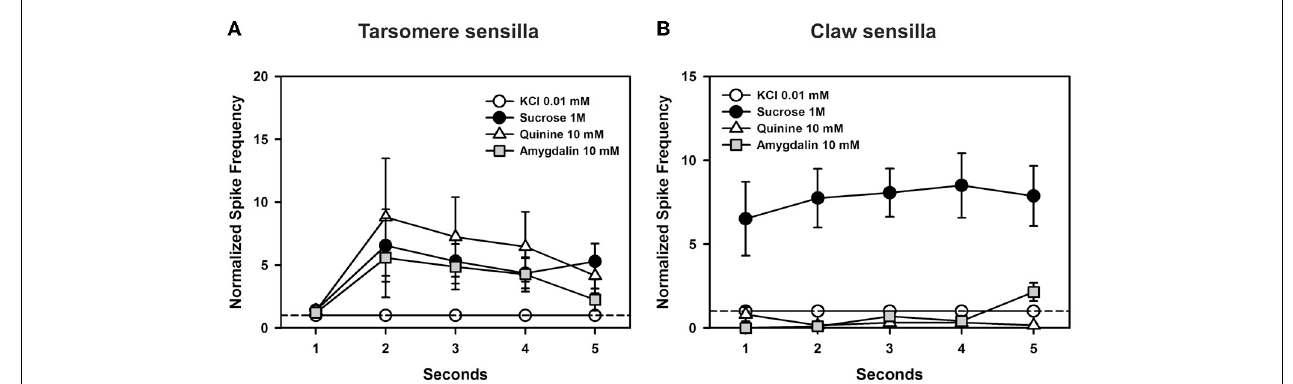
FIGURE 9 | Experiment 6. (A) Chaetic sensilla of the 3rd and 4th tarsomeres. Temporal analysis of mean normalized spike frequencies along five consecutive seconds of stimulation, starting at the onset and finishing at the offset of stimulation. The hatched line shows the reference response to the contact electrolyte KCl 0.01mM. Besides KCl, the curves show the temporal responses upon stimulation with sucrose 1 M, quinine 10mM, and amygdalin 10mM. There were significant differences between seconds of stimulation ( p < 0 . 0005) but within each second, the responses obtained for the different tastants were statistically similar. (B) Chaetic sensilla of the claws. Temporal